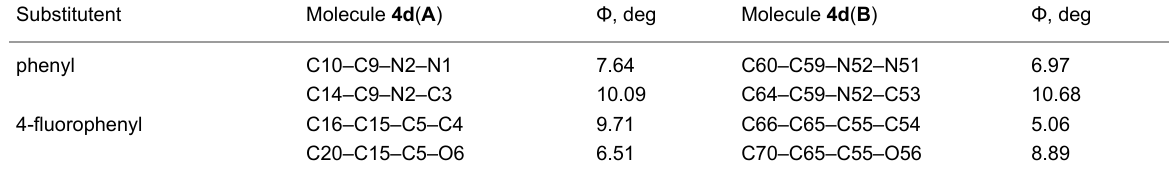
Table 3: Dihedral angles Φ formed by the phenyls and the 2 H -furo[2,3- c ]pyrazole core in 4d ( A ) and 4d ( B